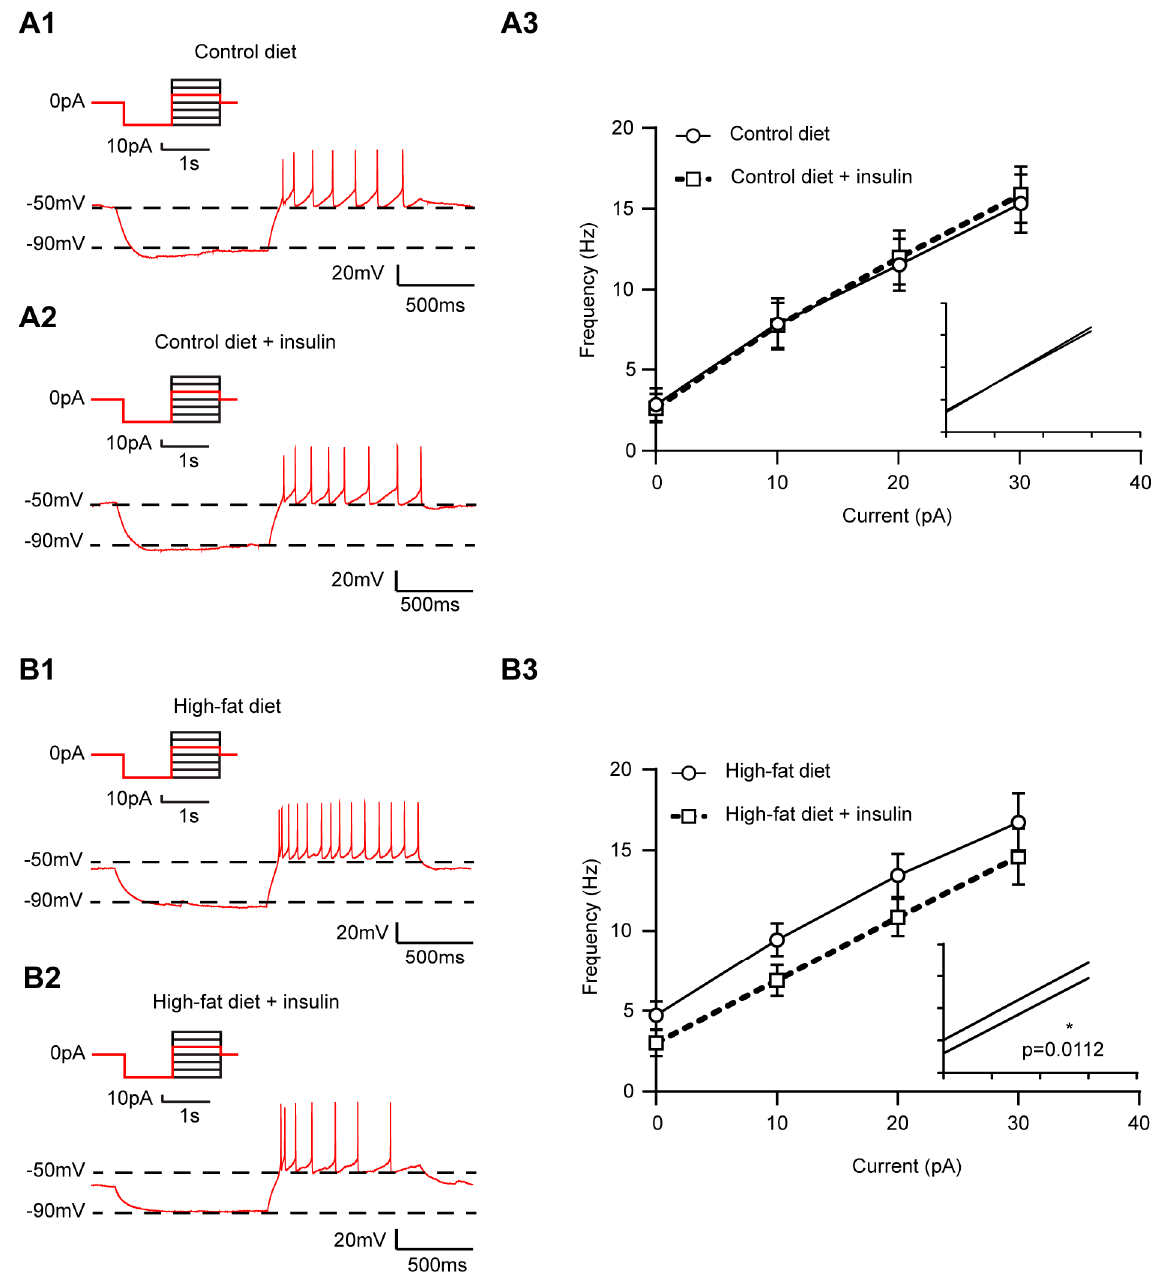
Figure 2. In HFD-fed mice, the firing of liver-related PVN neurons was reduced in response to insulin. ( A ): Representative traces illustrate the firing of liver-related PVN neurons before ( A1 ) and after ( A2 ) insulin application in control mice. The recorded neurons were initially hyperpolarized to ~ − 90 mV, then depolarizing current steps were applied to reveal the firing activity before and after insulin. Multiple current steps were applied; however, only one trace (+10 pA) is shown for better visibility. ( A3 ): In control mice, the current–action potential frequency relationship demonstrated that the firing of liver-related PVN neurons did not change in response to insulin. ( B ): Representative recordings illustrate the firing rate of a liver-related PVN neuron before ( B1 ) and after ( B2 ) bath application of insulin. ( B3 ): Current–action potential frequency responses to insulin and computed simple linear regression in HFD-fed mice demonstrate that liver-related PVN neurons fired less. HFD: high-fed diet, mEPSCs: miniature excitatory post-synaptic currents, mIPSCs: miniature inhibitory post-synaptic currents. * p < 0.05.